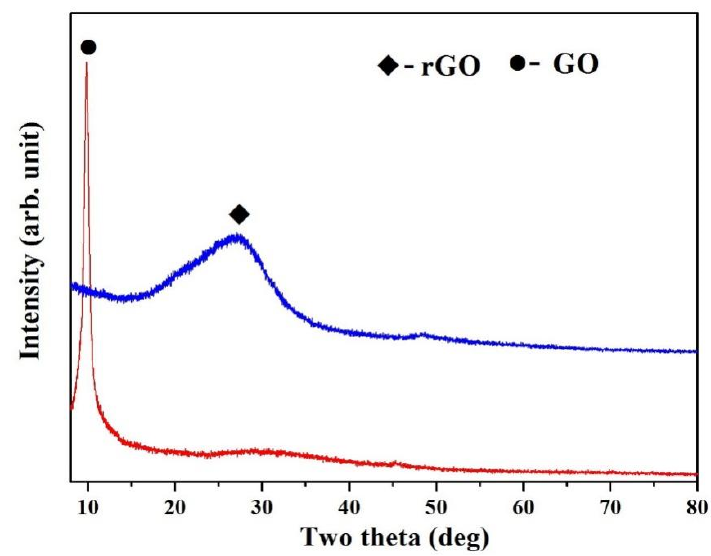
Figure 2. XRD patterns of rGO and GO.